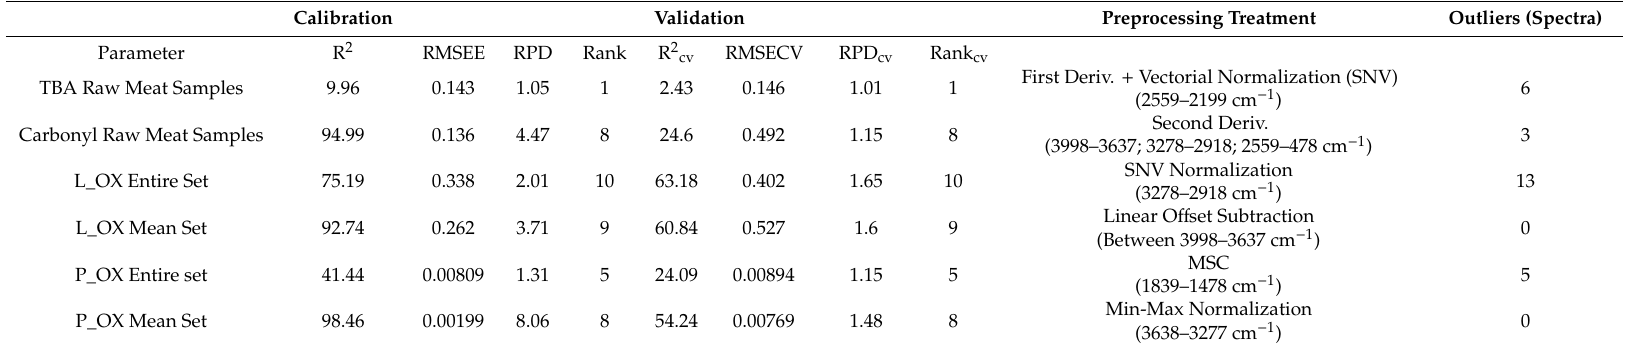
Table 6. Results of the predictive models (calibration and validation), of the TBA, and carbonyls content studied in raw meat and L_OX (lipid oxidation) and P_OX (protein oxidation) markers